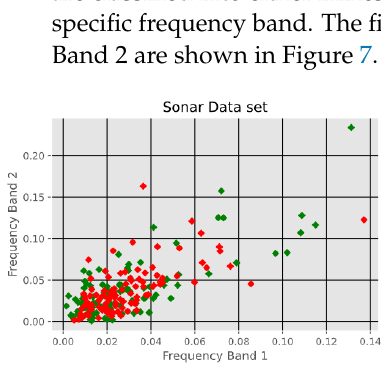
Figure 7. Illustration of the first two attributes of the Sonar data set.